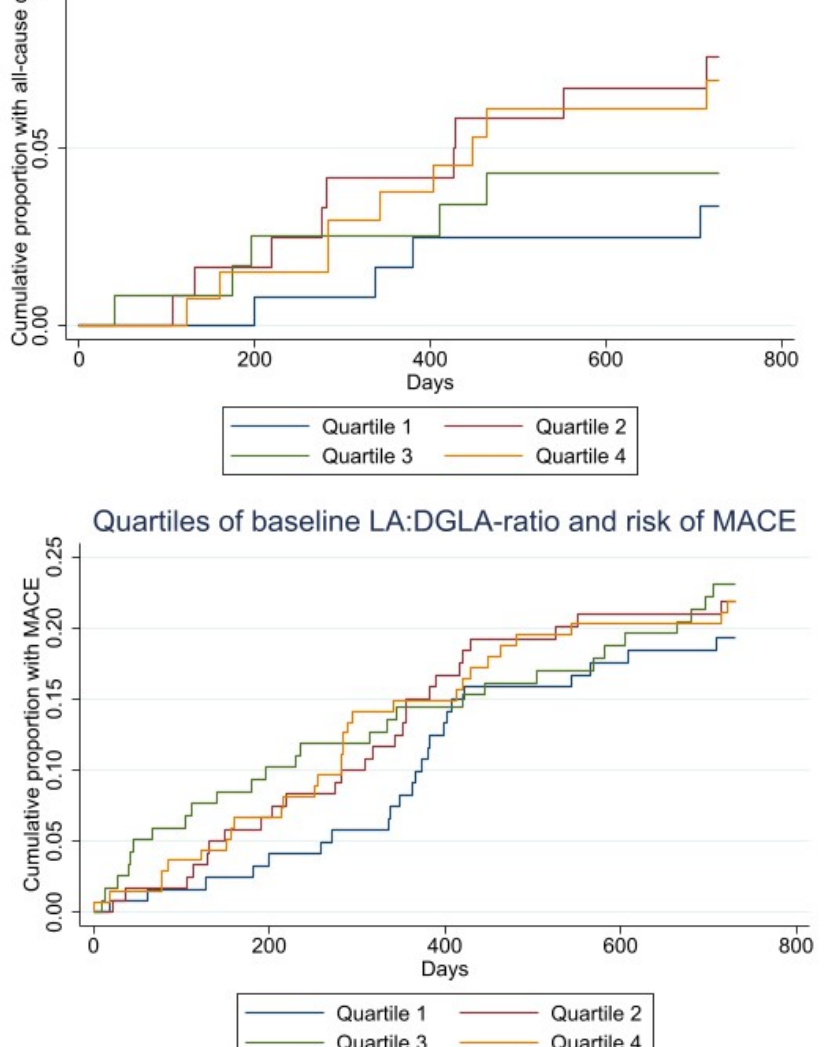
Figure 3. Kaplan–Meier curves for baseline LA:DGLA quartiles and all-cause death (upper). Meier curves for baseline LA:DGLA and risk of MACE Kaplan–Meier curves for baseline LA:DGLA and risk of MACE (lower).